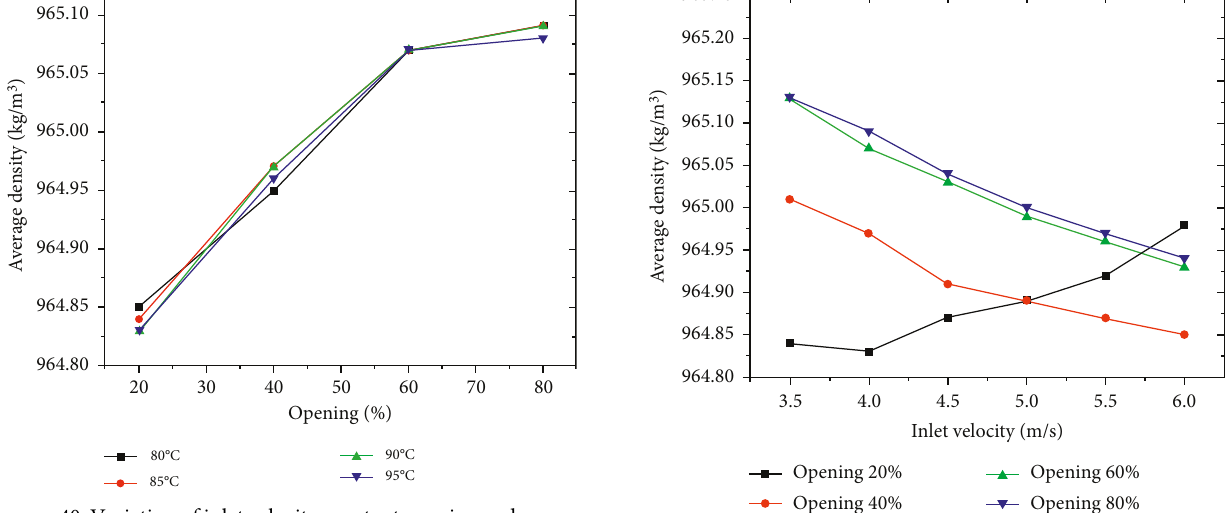
Figure 40: Variation of inlet velocity constant opening and average density with temperature.